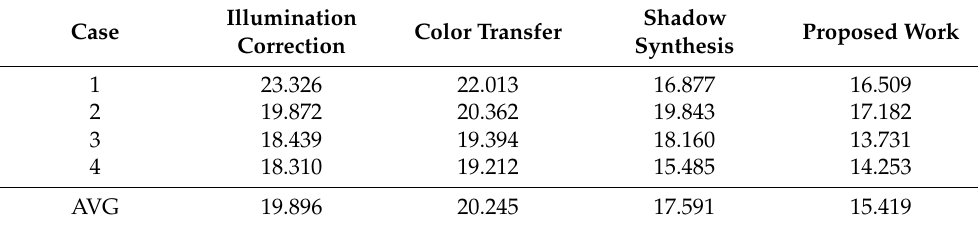
Table 4. Objective evaluation results of shadow standard deviation index (SSDI).